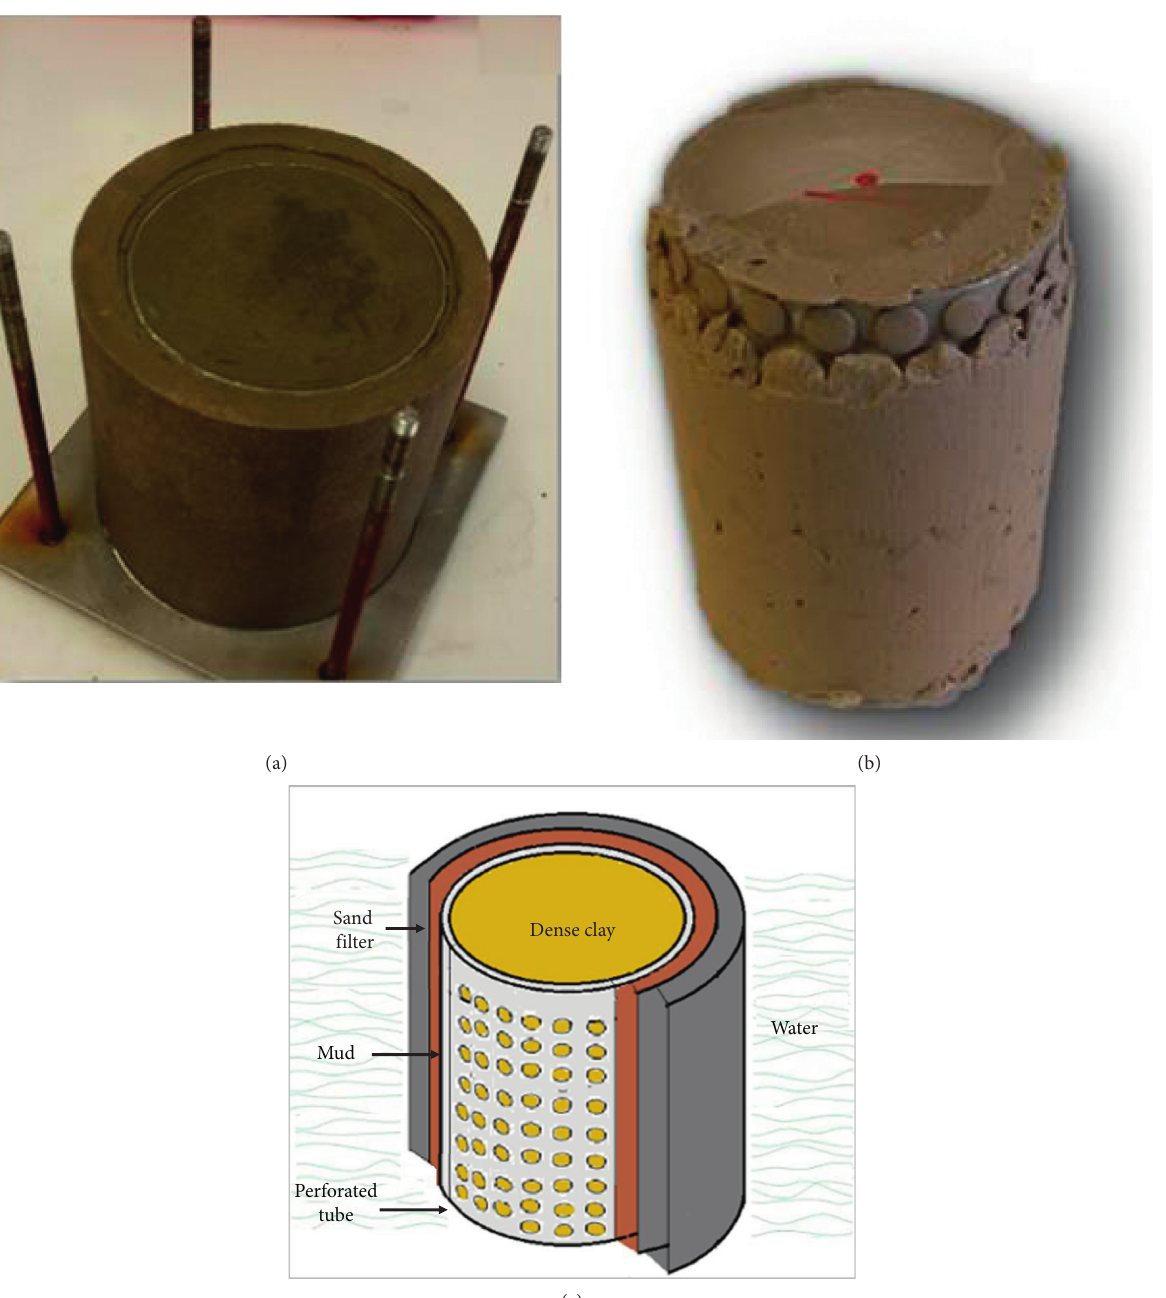
Figure 2: Instrument in the laboratory test. (a) Setup with clay seals after maturation, with the top lid removed; (b) 96-hour laboratory experiment with clay plugs in perforated steel tubes surrounded by mud; (c) schematic illustration of test setup with clay seals (soft clay mud and dense clay